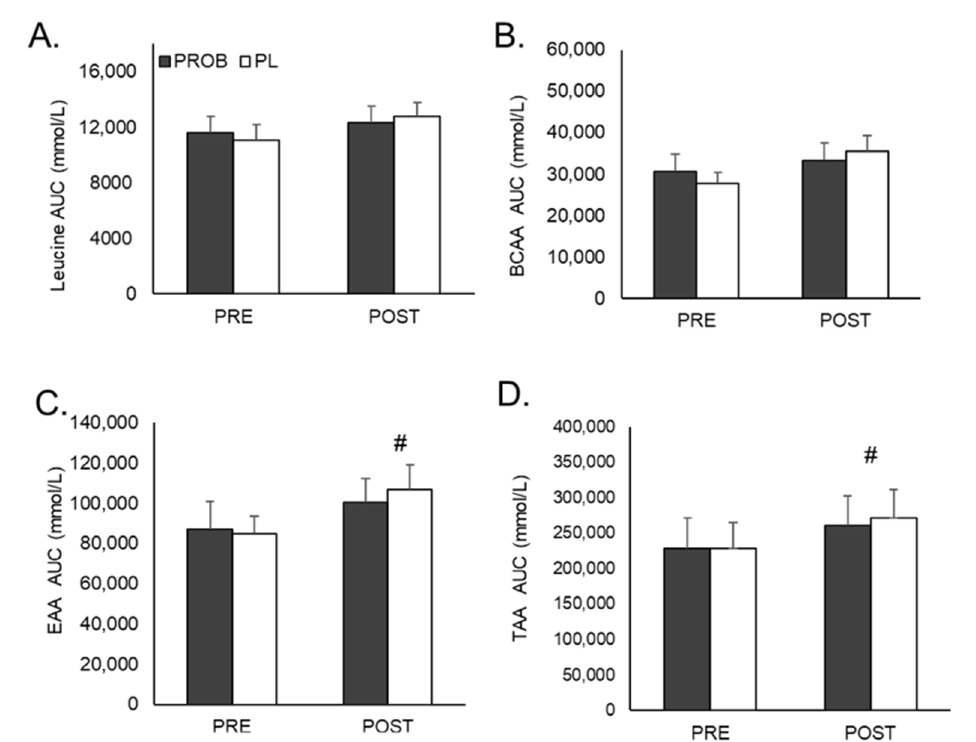
Figure 2. Area under the curve (AUC) values for plasma leucine ( A ), branched-chain amino acids (BCAAs; B ), essential amino acids (EAAs; C ), and total amino acids (TAAs; D ) from 0–120 min following consumption of 25 g of whey protein before (PRE) and after (POST) a 28-day supplement intervention. Groups: PROB: Bacillus subtilis DE111; PL: placebo. # main effect observed with higher values at POST. Values represent means ± SEM s.